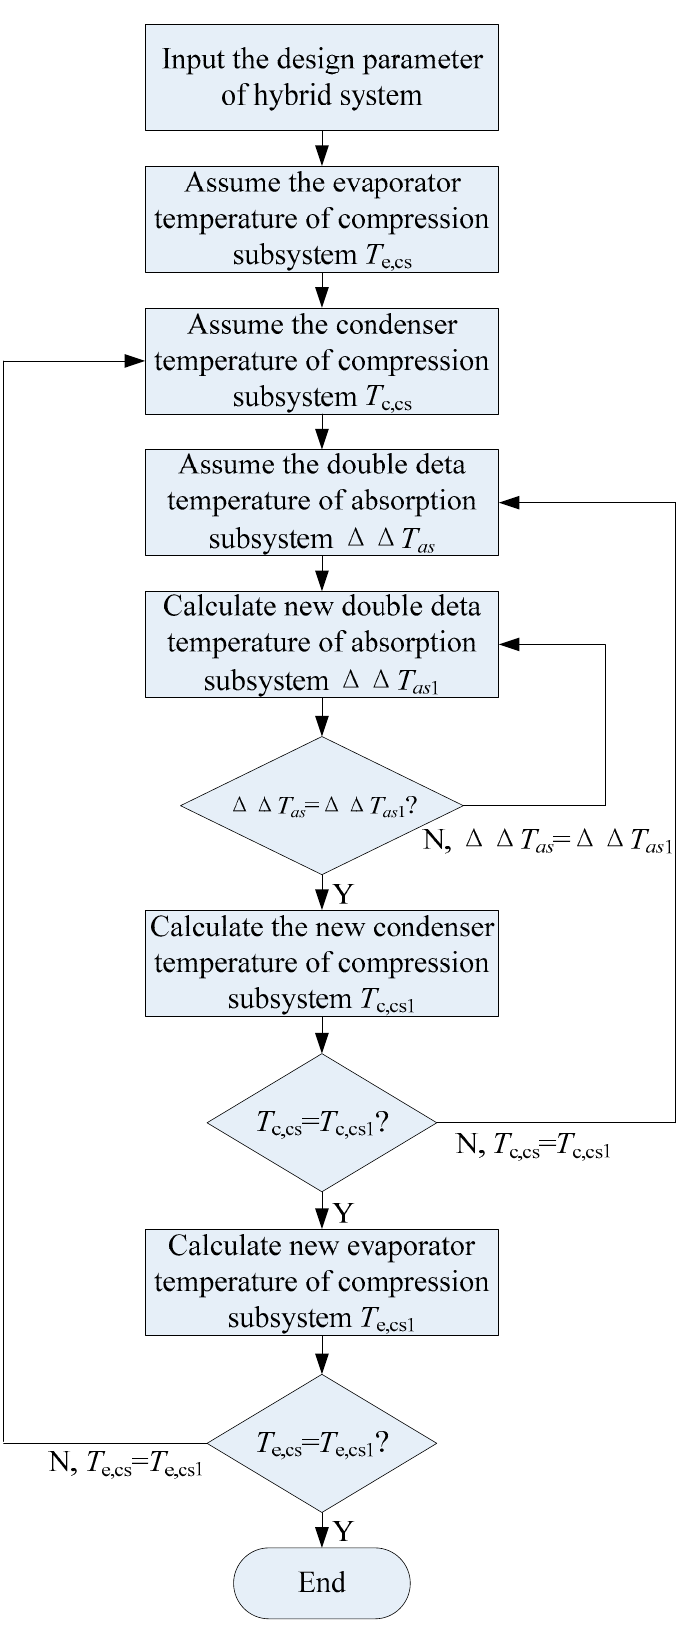
Figure 3. Solving process of model.